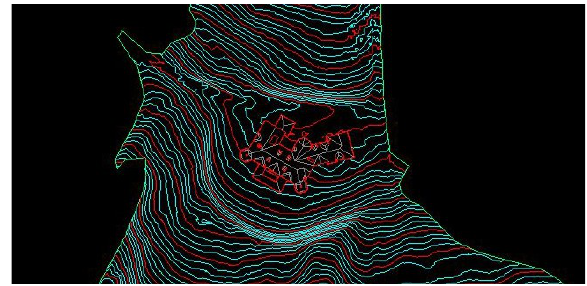
Fig.3 – Beinn Bhreagh 3D topography from